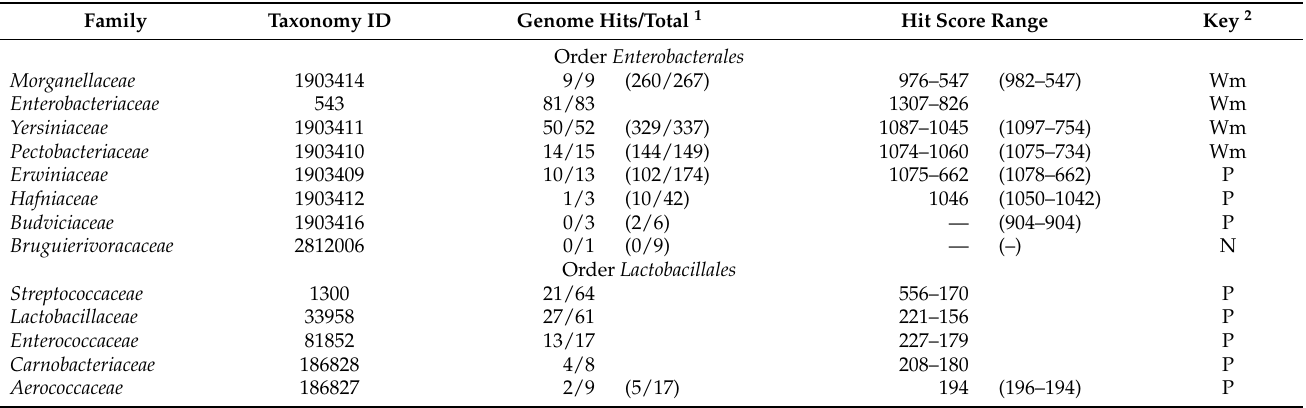
Table 5. Distribution of cpdB -like genes in different families of orders Enterobacterales and Lactobacil- lales , as obtained by TblastN analysis using S. enterica CpdB as the query.